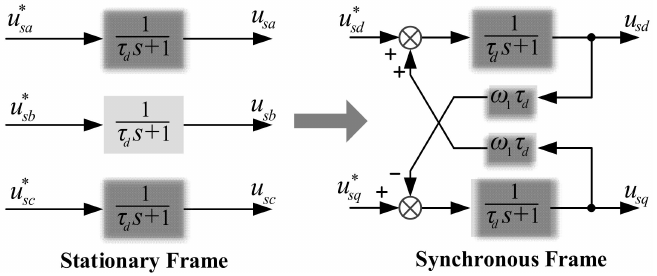
Figure 6. Coupling effect of digital control delay in the stationary/synchronous frame.